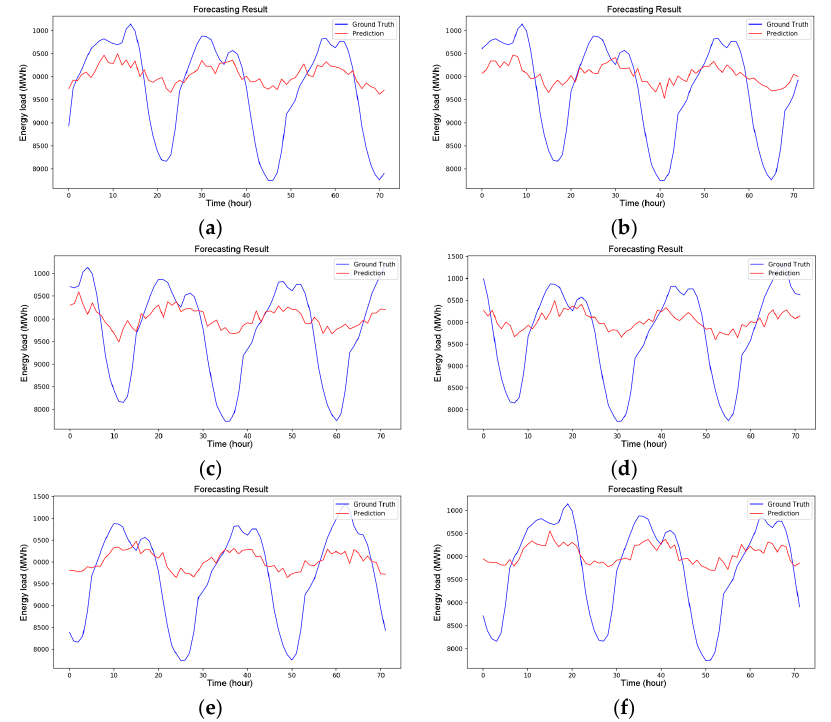
Figure 9. The forecasting results of Multilayer Perceptron (MLP): ( a ) Partial results A; ( b ) Partial results B; ( c ) Partial results C; ( d ) Partial results D; ( e ) Partial results E; ( f ) Partial results F.